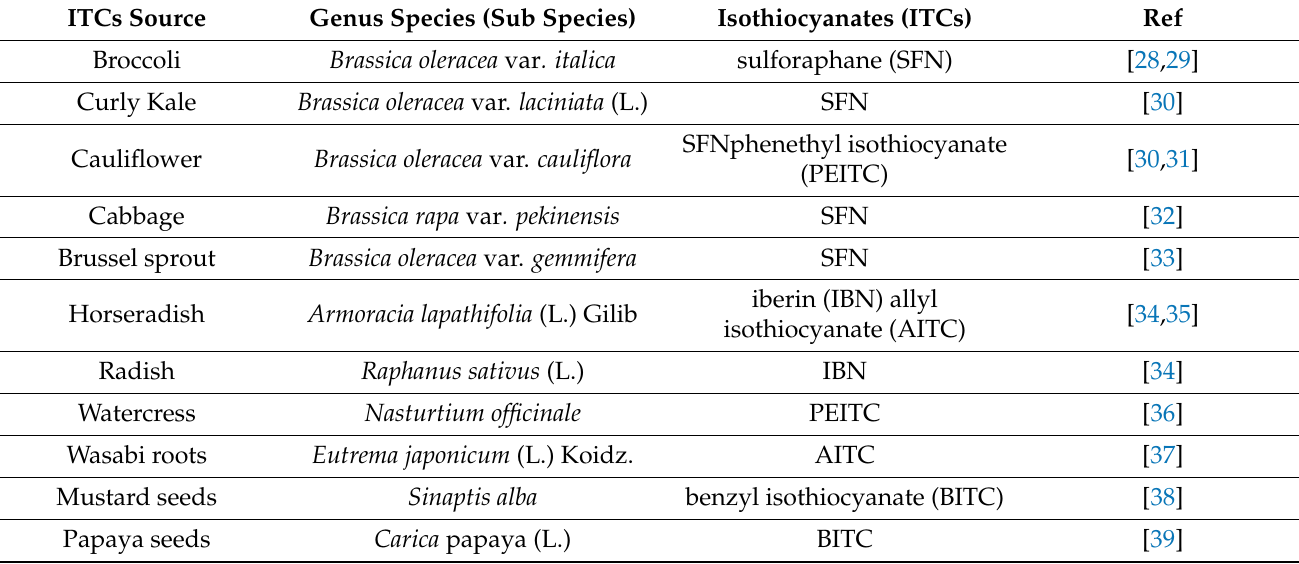
Figure 1. Schematic representation of the segregation of ITCs based on the type of the R group (sulfoxides, alkenyls, and aromatics). Table 1. Natural sources of ITCs including genus species.